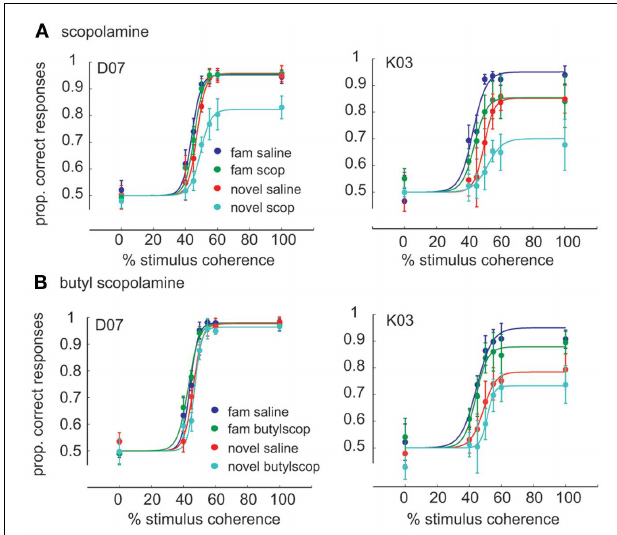
FIGURE 4 |Average psychometric functions of the behavioral performance for the two monkeys, (A) Effect of scopolamine on the performance of the categorization task for monkey. D07 (seven scopolamine experiments, 7.5–10 μ g/kg dose) and monkey K03 (four scopolamine experiments, 7.5 μ g/kg dose). On the Y axis is plotted the proportion of correct responses (probability of a correct response, mean ± 1SE).The color coding scheme is indicated in the lower right. Both animals showed worst performance when categorizing novel images under scopolamine. (B) Butyl-scopolamine experiments: performance under butyl-scopolamine (2–4mg/kg), a scopolamine analog that cannot cross the blood brain barrier (three and six experiments, respectively). Experiments within a panel consist of scopolamine and control experiments on successive days whereas comparisons between panels involve experiments spaced potentially weeks or months apart.